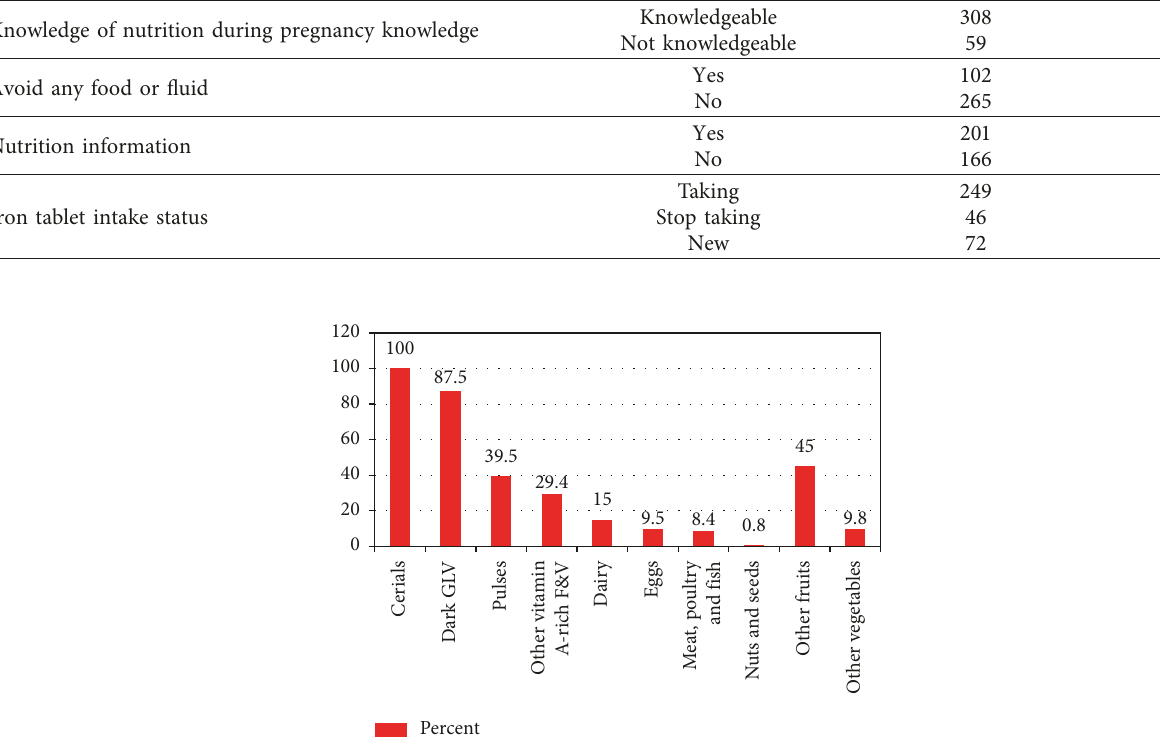
Table 2: Nutritional practice of pregnant mothers in South West-Ethiopia, in February 2020 ( n � 367).